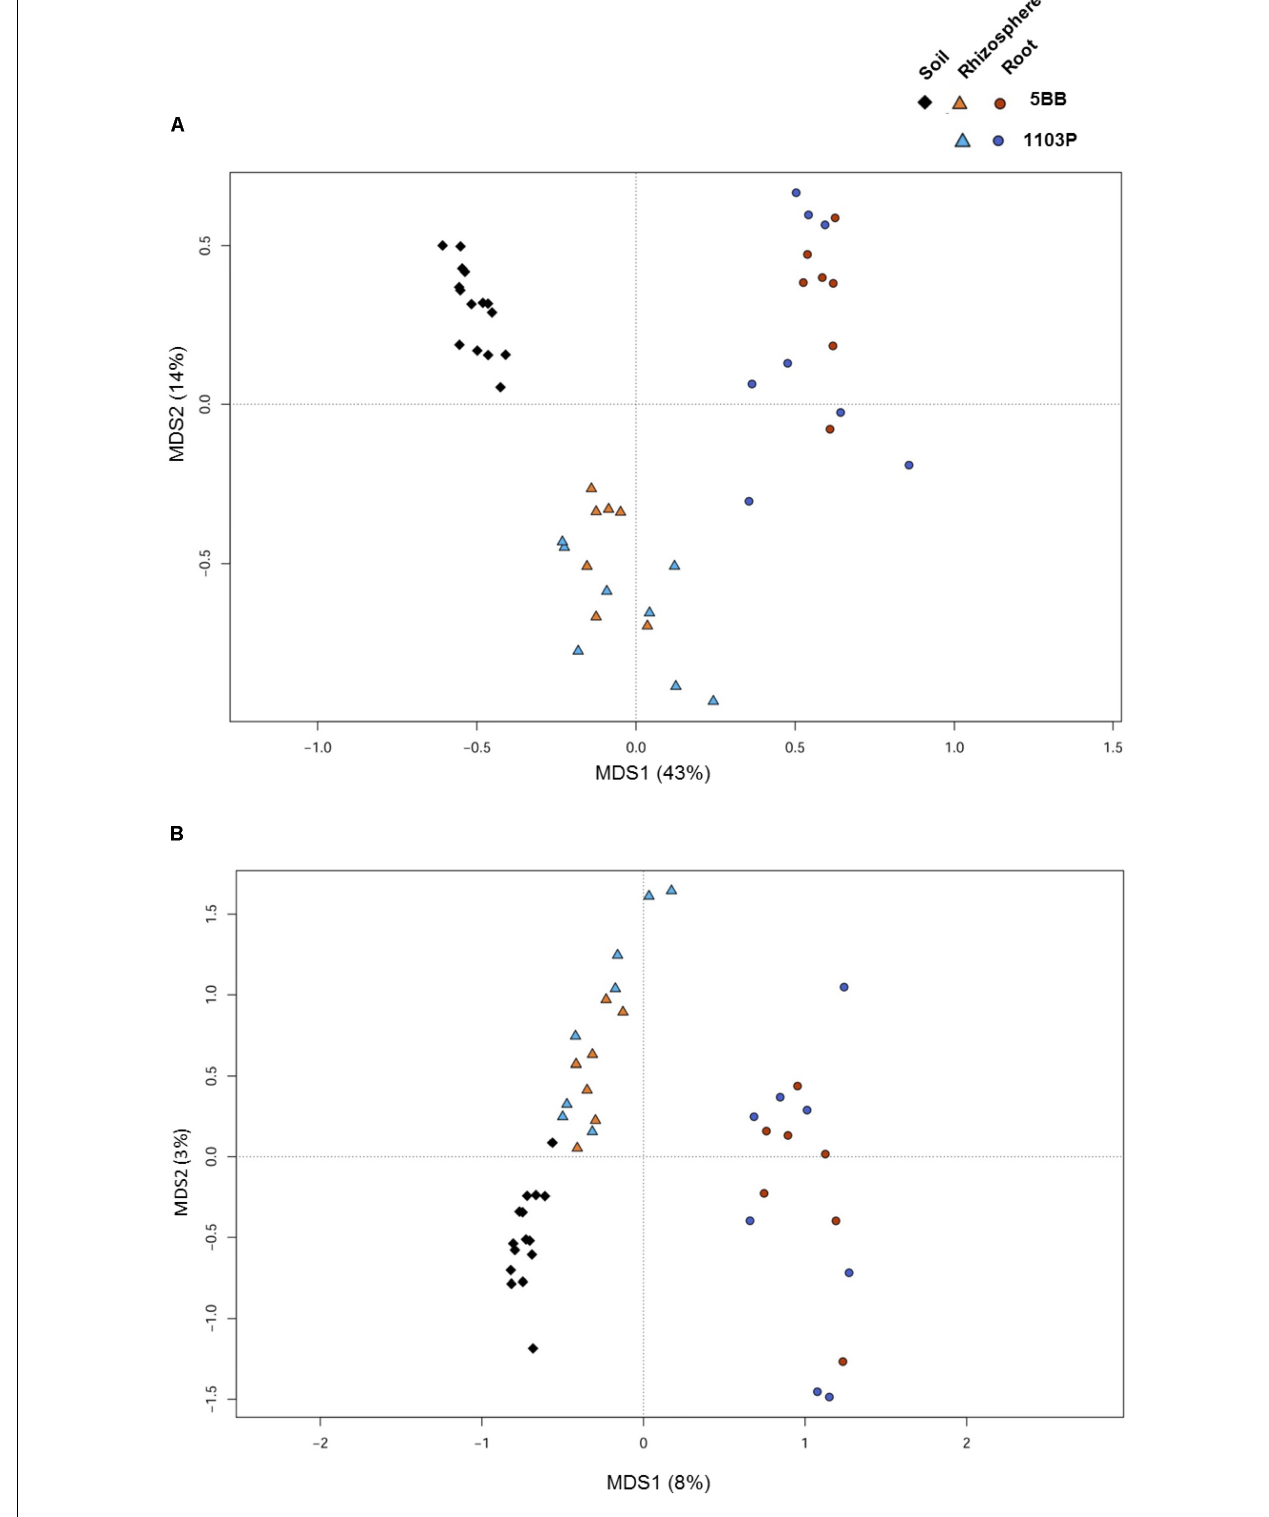
Frontiers in Microbiology |